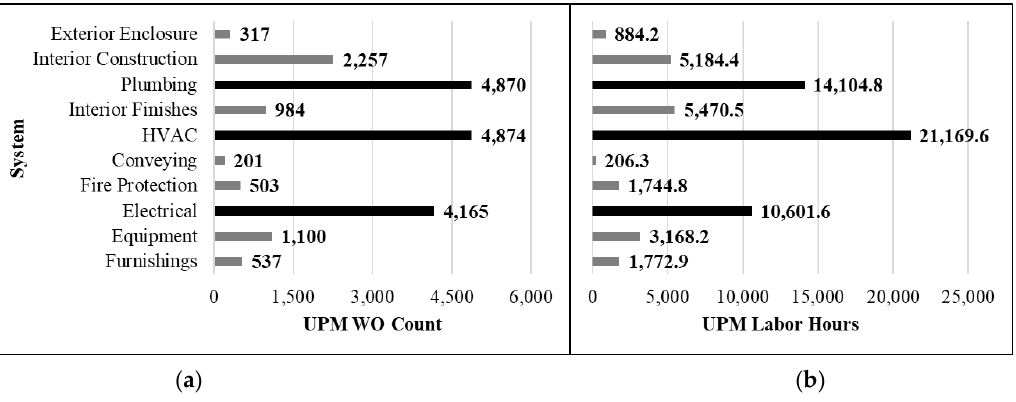
Figure 10. System-level comparison of the UPM: ( a ) Work Order Counts; ( b ) Labor Hours.